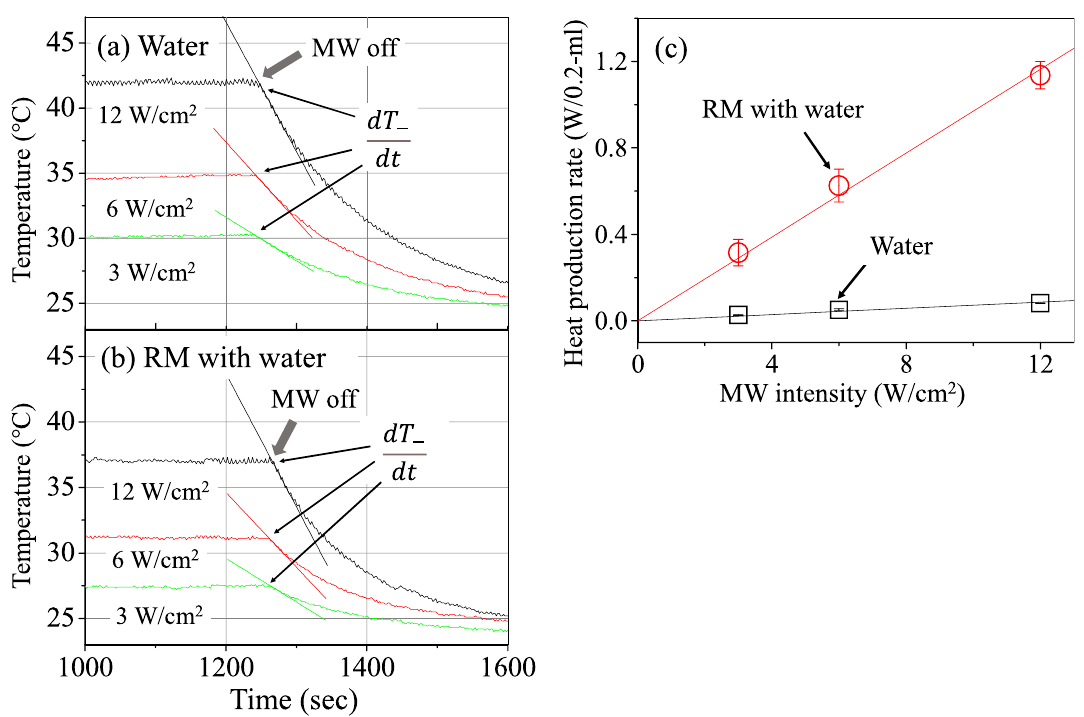
Figure 3. Real-time changes in the temperatures descending from the stationary states owing to turning off the MW for samples of water ( a ) and RM solution with water ( b ) at three MW intensities, where black, red, and green curves are the results at MW intensities of 3, 6, and 12 (W/cm 2 ), respectively. The straight lines correspond to the first derivation ( dT _/ dt ) at the time when the MW is turned off. ( c ) Heat production rates (W/0.2-ml water) due to water for liquid water (black squares) and for the RM solution (red circles) as a function of MW intensity, where the mean values with standard deviations (error bars) are shown, obtained from the measurements made three times. The straight lines (red for RM, black for water) were gained by least- squares fitting to the data with coefficients of determination of 0.97 for RM solution and of 0.92 for